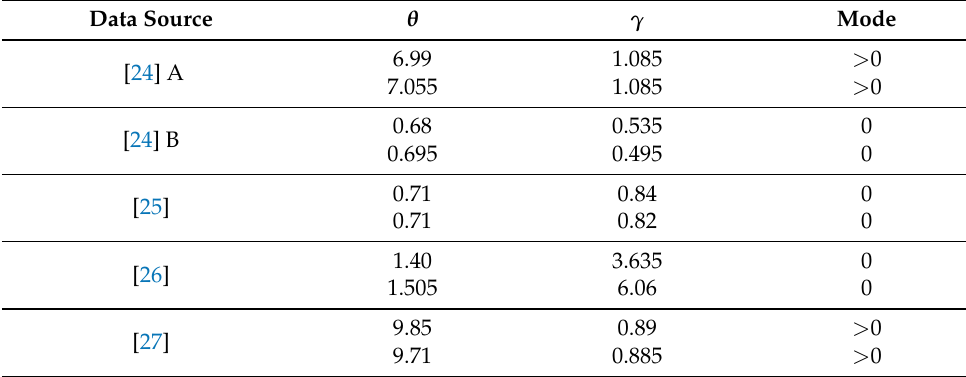
Table 1. Estimated θ and γ by MLE (upper rows) and empirical PGF (lower